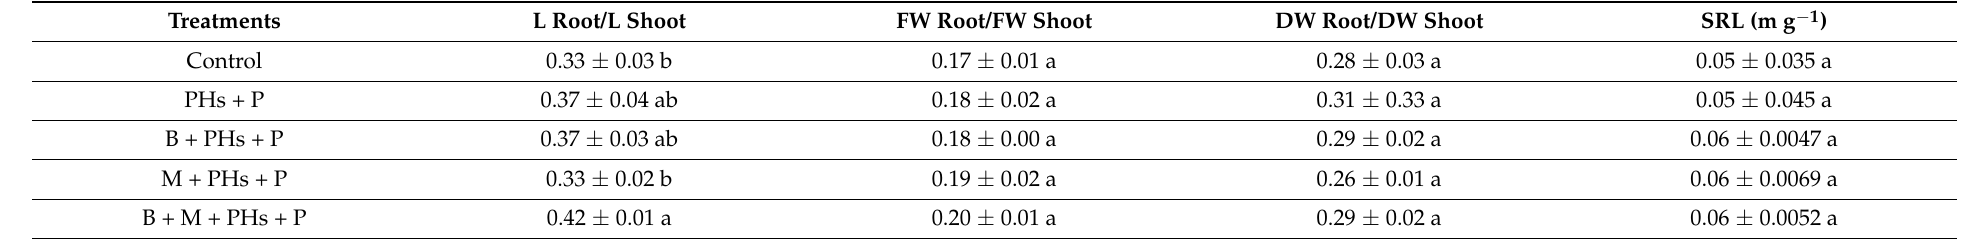
Table 2. Root-shoot ratio and specific root length of maize plants after